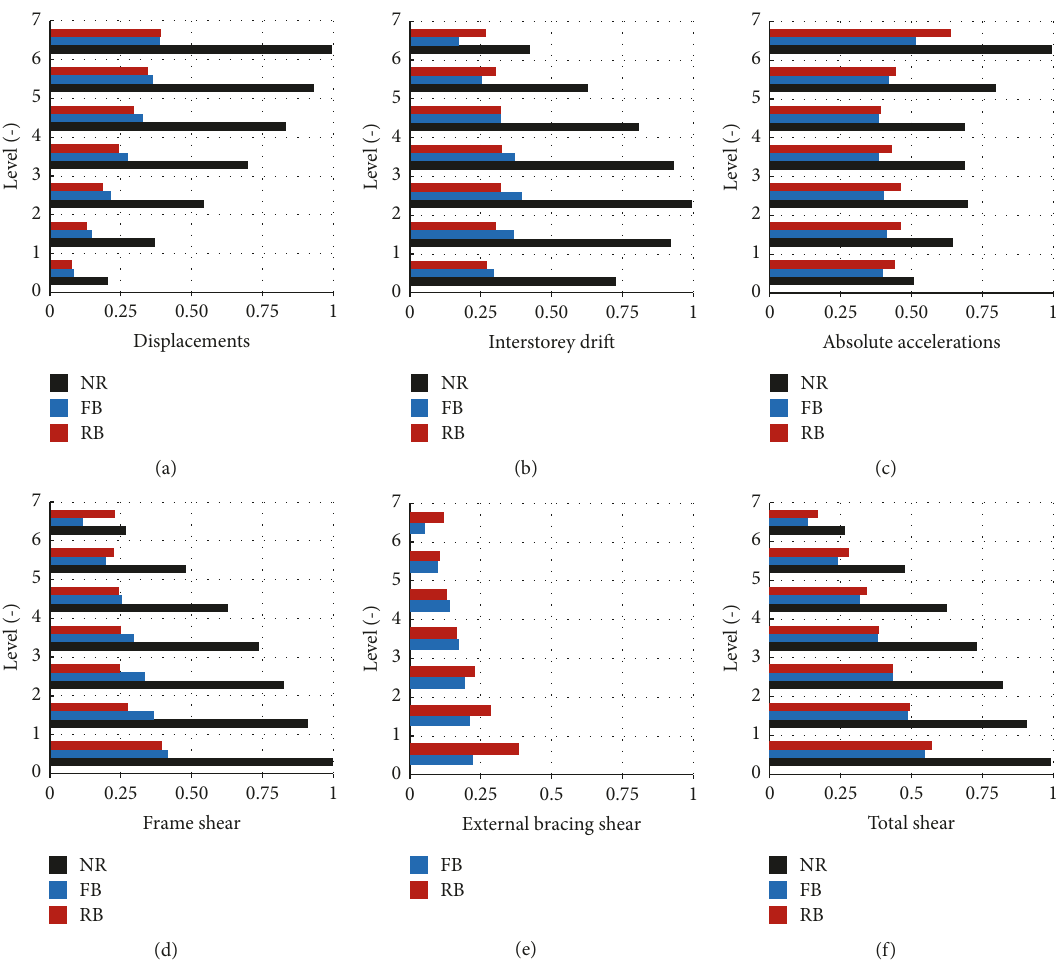
Figure 10: Comparison of the seismic performance of the NR, FB, and RB configurations in terms of parameters of